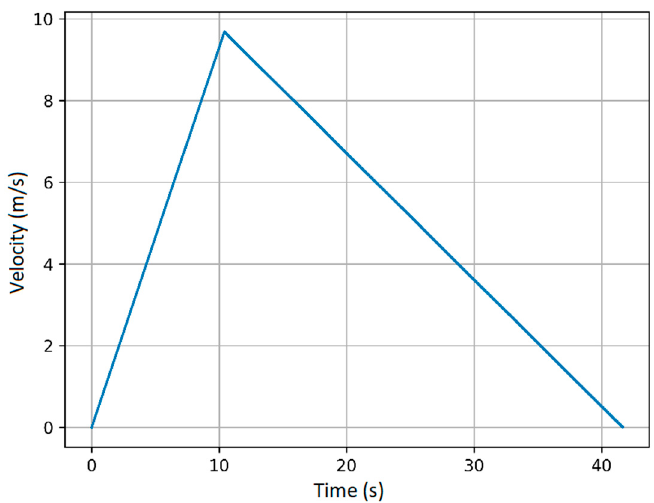
Figure 15. Velocity profile for the example path for the map 1.